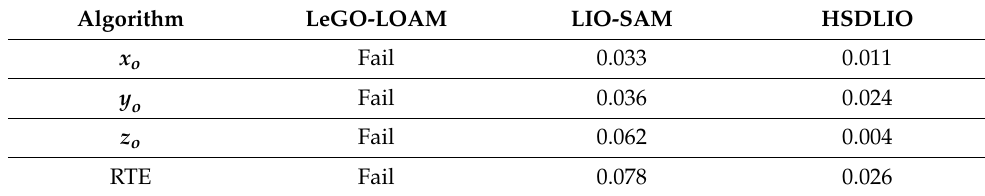
Figure 13. Comparison of the height information of LIO-SAM and HSDLIO in the z direction. The trajectory of HSDLIO provides height information from going up and down four floors of stairs, while LIO-SAM failed to position in the z direction. Table 2. Relative translational error when the backpack returns to the starting point (meters).